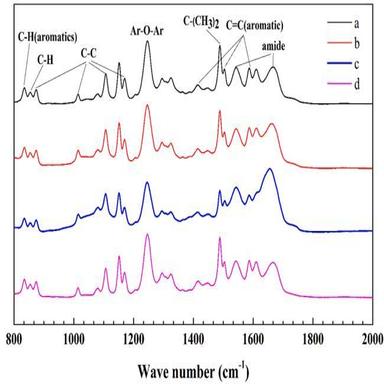
FTIR spectra: (a) Virgin membrane, (b) Membrane fouled by ROC, (c) Membrane fouled by ROC pretreated with AOPs-UF, (d) Mixed cleaned membrane.